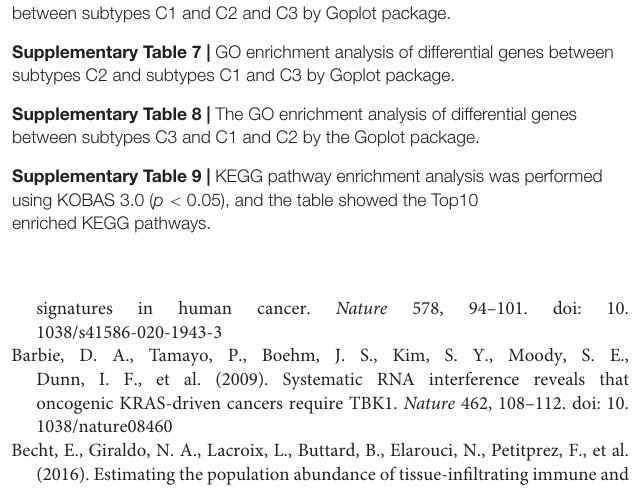
green representing miRNA. Supplementary Table 1 | The information of clinical characteristics of TCGA-SKCM cohorts. Supplementary Table 2 | Independency test between meta cluster and other clinical information and previous classification in TCGA-SKCM cohorts. Supplementary Table 3 | Independency test between meta cluster and other clinical information in GEO-SKCM cohorts. Supplementary Table 4 | The ratio of driver-type oncogenic mutations based on TCGA-SKCM in each subtype. Supplementary Table 5 | The gene list of the 90 gene-classifier. Supplementary Table 6 | Analysis of GO enrichment of differential genes between subtypes C1 and C2 and C3 by Goplot package. Supplementary Table 7 | GO enrichment analysis of differential genes between subtypes C2 and subtypes C1 and C3 by Goplot package. Supplementary Table 8 | The GO enrichment analysis of differential genes between subtypes C3 and C1 and C2 by the Goplot package. Supplementary Table 9 | KEGG pathway enrichment analysis was performed using KOBAS 3.0 ( p < 0.05), and the table showed the